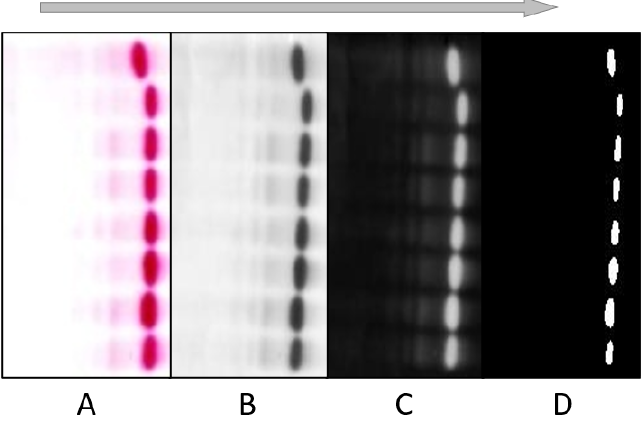
Figure 6. Pre-processing techniques applied to a sample test image: ( A ) raw ( B ) RGB to grayscale conversion, ( C ) image complementation, ( D ) thresholding of electrophoresis